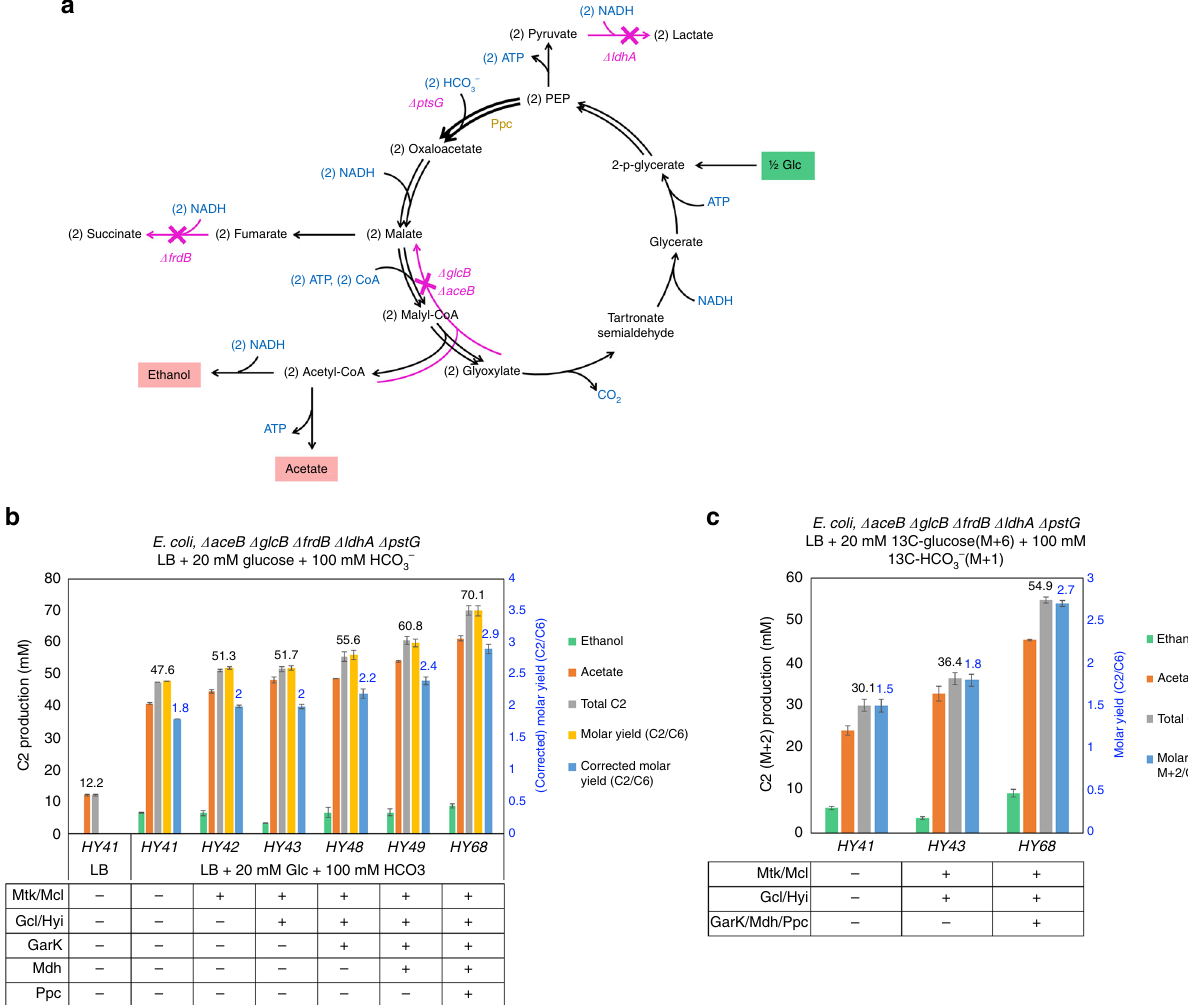
Fig. 3 Functional demonstration of the MCG pathway in E. coli . a Rationale of gene deletions in the E. coli strain ( Δ aceB Δ glcB Δ frdB Δ ldhA Δ ptsG ) used to investigate the effect of the MCG pathway. Deletions of frdB and ldhA were to eliminate the production of succinate and lactate. Deletions of glcB and aceB were to avoid the reverse reaction of Mtk/Mcl. Deletion of ptsG was to increase the intracellular PEP level. b Construction of the MCG pathway in E. coli increased the production of C2 compounds. After 24 h, 20 mM glucose was consumed. Expression of the complete pathway genes increased the titer of C2 compounds to 70.1 mM, which corresponds to the corrected C2/Glucose molar yield of 2.9, approaching the maximum theoretical value of 3 in E. coli . Molar yield (C2/C6) is calculated as the total C2 compounds (mM) produced divided by 20 mM glucose consumed. Corrected molar yield (C2/C6) refers to the total C2 compounds (mM) minus the C2 (12.2 mM acetate) produced in LB only, and then divided by 20 mM glucose consumed. c 13C isotopic measurement of total C2 (M + 2) production in LB medium supplemented with 20 mM 13 C uniformly labeled glucose (M + 6) and 100 mM 13C NaHCO 3 (M + 1) under oxygen-limited condition. After 24 h, 20 mM glucose (M + 6) was consumed. Expression of the complete pathway genes achieved the C2 (M + 2)/C6(M + 6) molar yield to 2.75, signi fi cantly exceeding the theoretical yield ( = 2) of wild type. Error bars are s.d., n = Δ frdB Δ ldhA Δ pstG , was created (Fig. 3a). LdhA 23 and FrdABCD 24 are lactate dehydrogenase and fumarate reductase